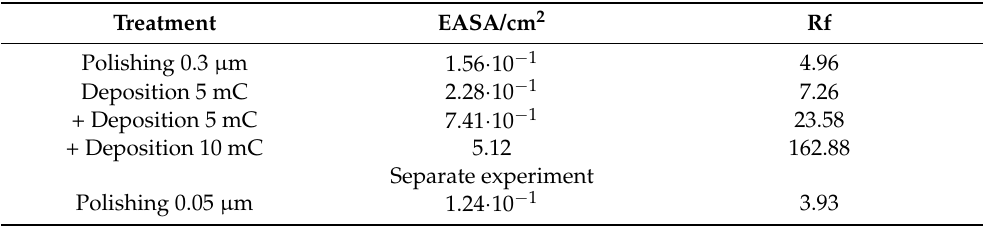
Table 2. Roughness factor (Rf) and EASA of platinum surface with enhanced roughness using platinum deposition.